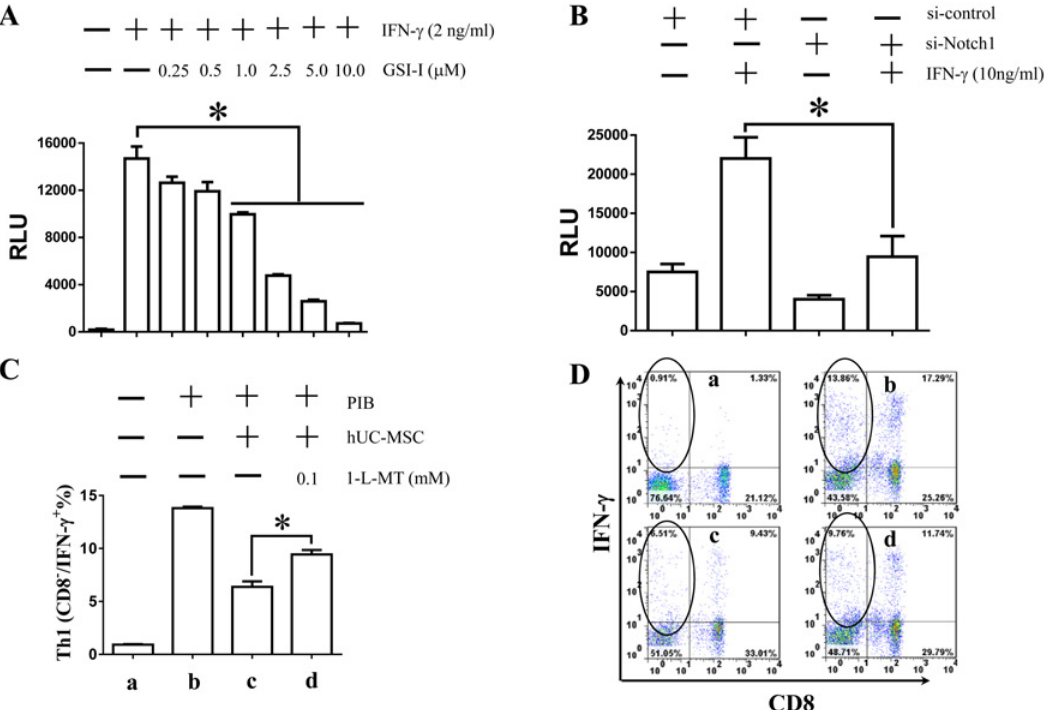
Fig 9. The Notch1 signaling is involved in immunomodulation of hUC-MSCs through promoting IDO1 transcription. A. Luciferase assay shows that, after transfection with pIDO1-Luc, the IDO1 promoter can be significantly activated in hUC-MSCs by 2 ng/mL IFN- γ . However, such activity can be significantly inhibited by GSI-I in a dose-dependent manner. B. Luciferase assay shows that siNotch1 transfection reduces over 50% of the IDO1 promoter activity. The * indicates statistical significance with p < 0.05. C. Flow cytometry assay shows that treatment with 0.1 mM 1-L-MT during co-culturing of hUC- MSC and PBMCs can significantly reduce the effect of hUC-MSCs on inhibition of Th1 lymphocyte proliferation. The * indicates statistical significance with p < 0.05 D. D. The flow cytometry blot data are corresponding to the results of Fig. 9C. The Th1 lymphocytes circled in the plot are the CD8 - /IFN- γ +